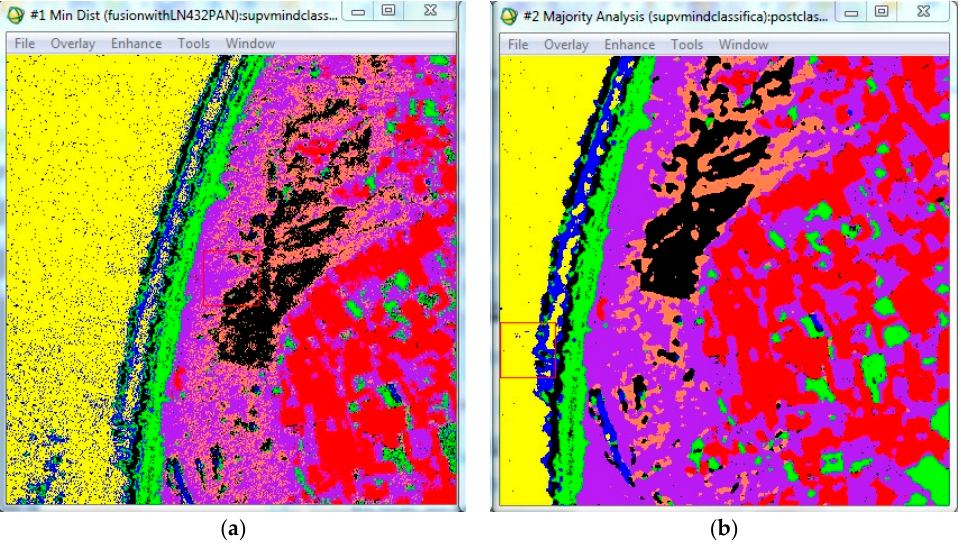
Figure 8. ( a ) Minimum distance classification; ( b ) Majority analysis for smoothing.